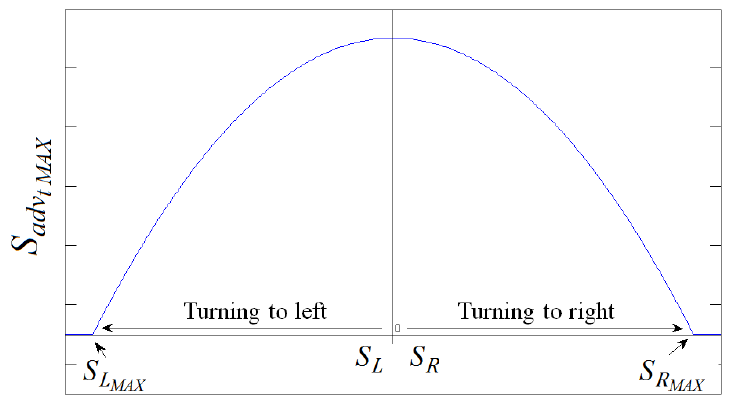
Figure 16. Advance speed correction according to the turn speed.